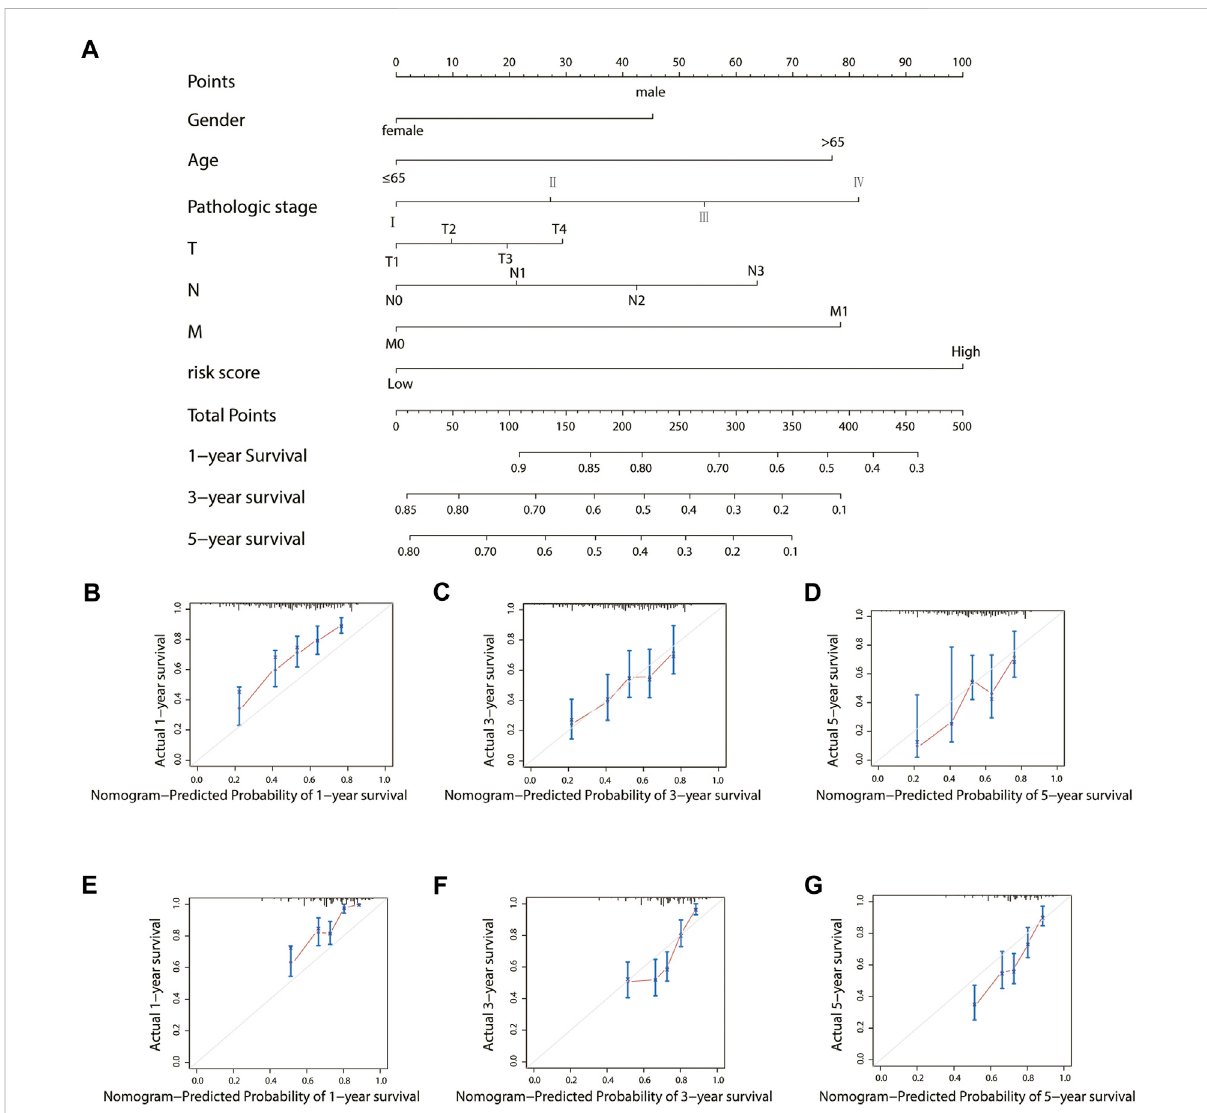
FIGURE 9 Construction and validation of a nomogram for the overall survival prediction in stomach adenocarcinoma. (A) Nomogram of TCGA cohort. (B – D) Calibration curves ofthenomogramfor theestimationof overall survivalratesat1-, 3-, and5-yearsinTCGA cohort. (E – G) Calibration curves of the nomogram for the estimation of overall survival rates at 1-, 3-, and 5- years in the GEO validation